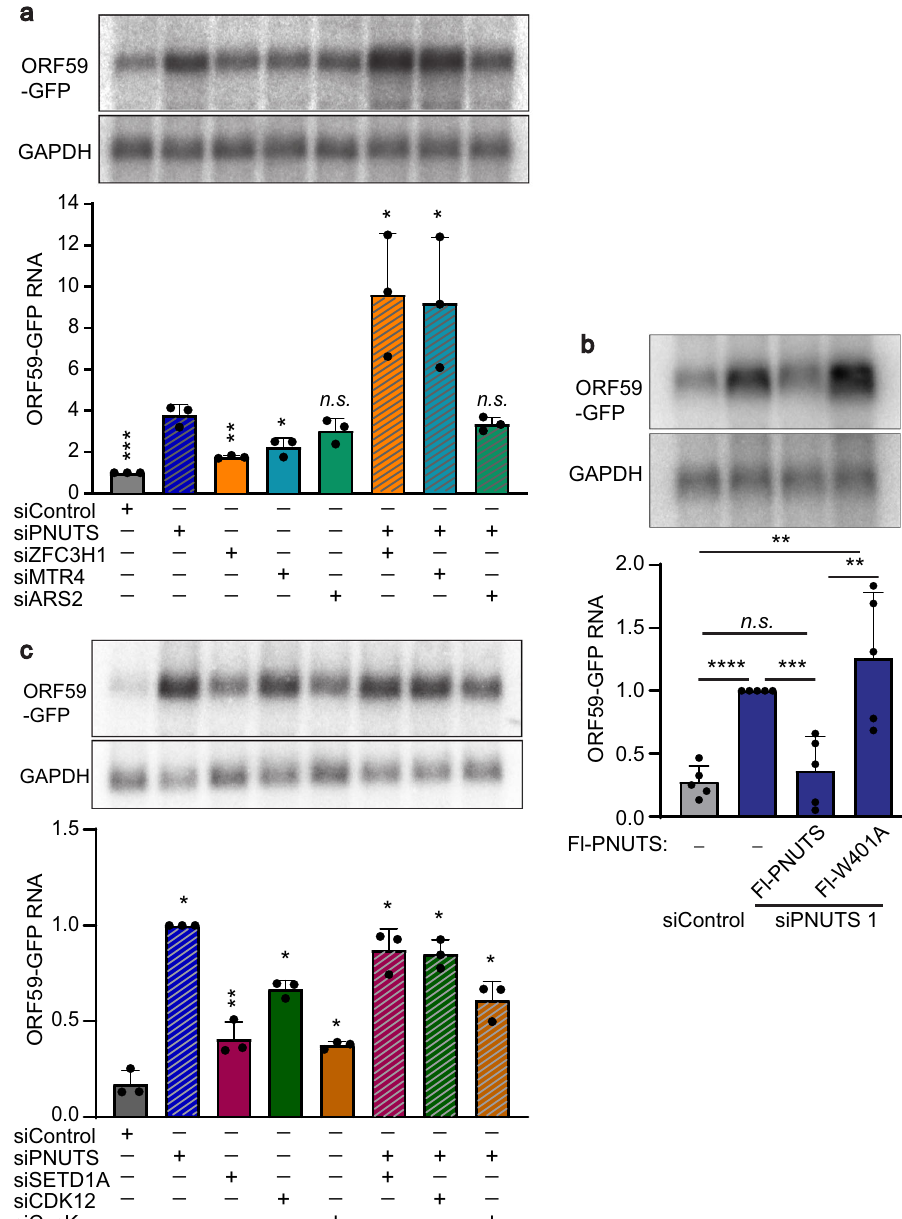
Fig. 4 | PNUTS-mediated suppression of ORF59-GFP correlates with its PP1- dependent transcriptional functions. a Representative northern blot and quan- ti fi cation of ORF59-GFP from the reporter line treated with the indicated siRNAs. Values were normalized to GAPDH and quanti fi ed relative to siControl. Error bars are mean with standard deviation, asterisks denote Student ’ s two-tailed unpaired t-testscomparedtosinglesiPNUTSknockdown:(siControl*** p =0.0007,siZFC3H1 ** p =0.0025, siMTR4 * p =0.0164, siARS2 n.s. p =0.1733, siPNUTS/siZFC3H1 * p =0.0278, siPNUTS/siMTR4 * p =0.0428, siPNUTS/siARS2 n.s. p =0.2810), ( n =3). b Representative northern blot and quanti fi cation of ORF59-GFP RNA from HEK293A-TOA cells treated with siRNAs and then transiently transfected with pAAVS1-ORF59-GFP-Hyg and empty vector, Fl-PNUTS, or Fl-W401A (both with siRNA-refractory silent mutations). RNA was harvested at 72h post-transfection